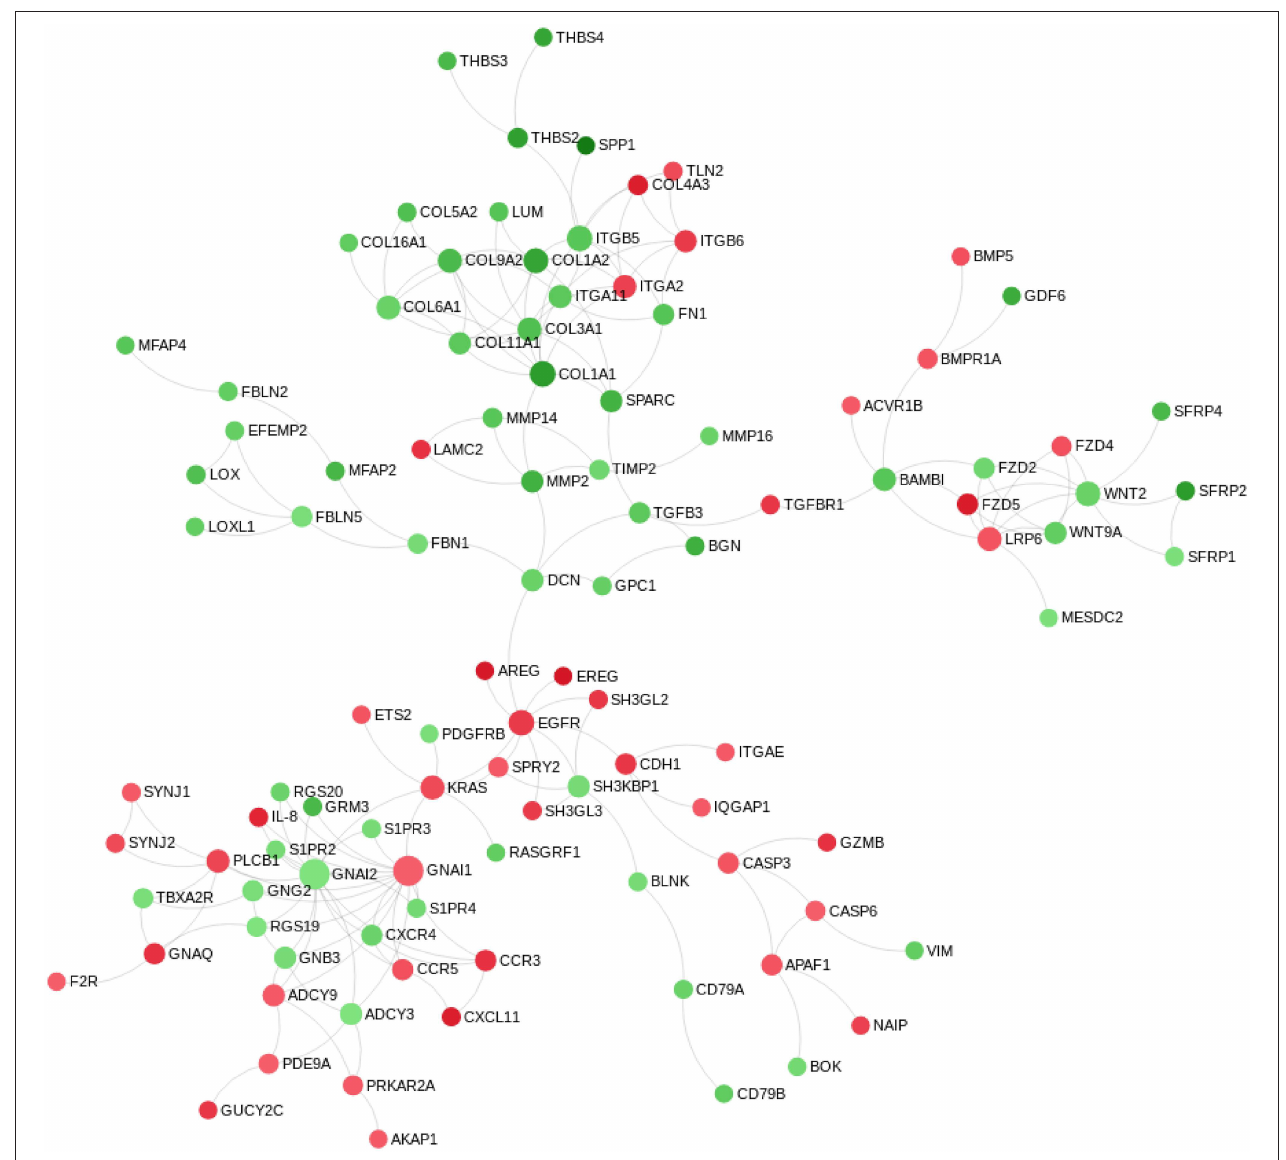
FIGURE 5 | Zero-order protein-protein interaction network of differentially expressed genes comparing MAP-infected DPP to PBS control intestinal segments. Data was drawn using NetworkAnalyst (57). Red, upregulated; green, downregulated. Node size reflects the number of protein-protein interactions, with larger nodes representing a greater number of annotated